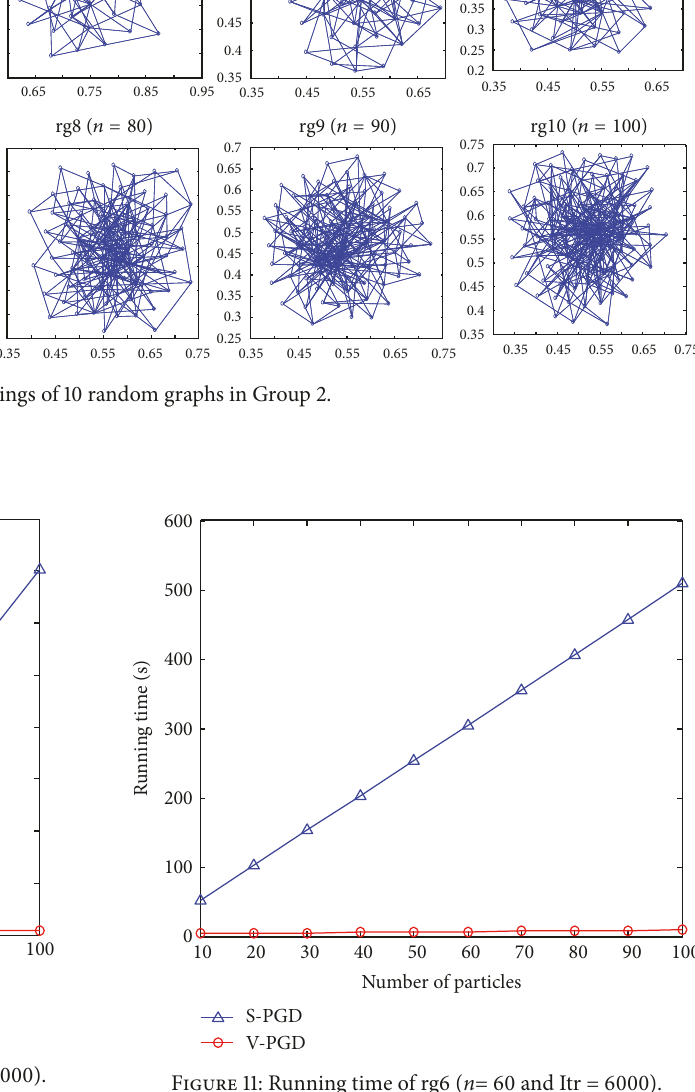
The relationships between the fitness values and the number of particles using V-PGD for graphs g7, g14, and g K